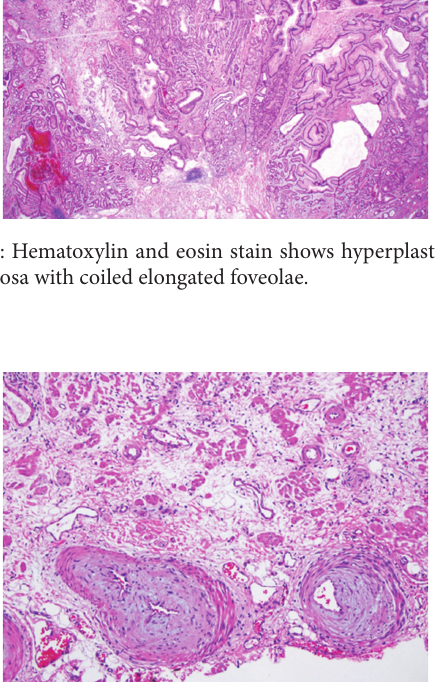
Figure 6: Hematoxylin and eosin stain shows bland spindle cell proliferation adjacent to polyp consistent with